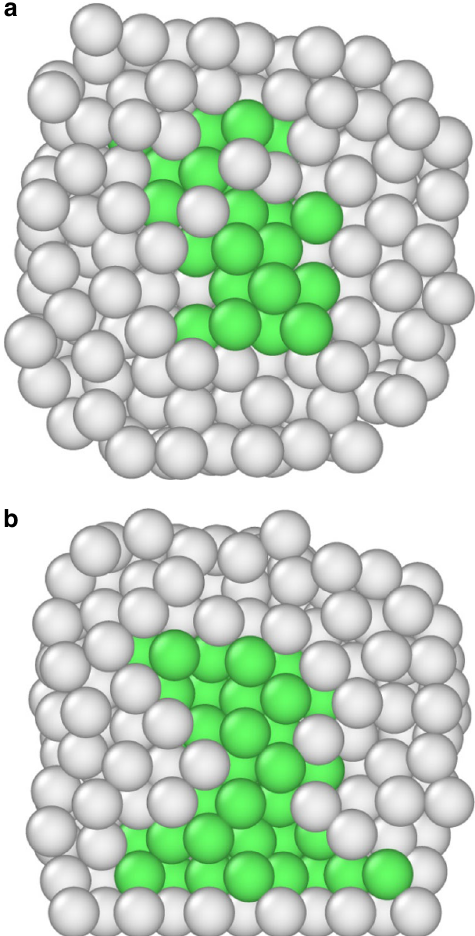
Fig. 6 Cross-sections of Au 561 nanoclusters at elevated temperatures. a A free and b a frozen-facet nanocluster at 627°C. Green spheres denote atoms that are recognized as fcc, while grey spheres are atoms found to be non- crystalline. The bottom layer in ( b ) is the frozen layer. At this temperature the core is approximately double in size in ( b ) compared with ( a ) (85 atoms and 43 atoms, respectively) and displaced towards the frozen